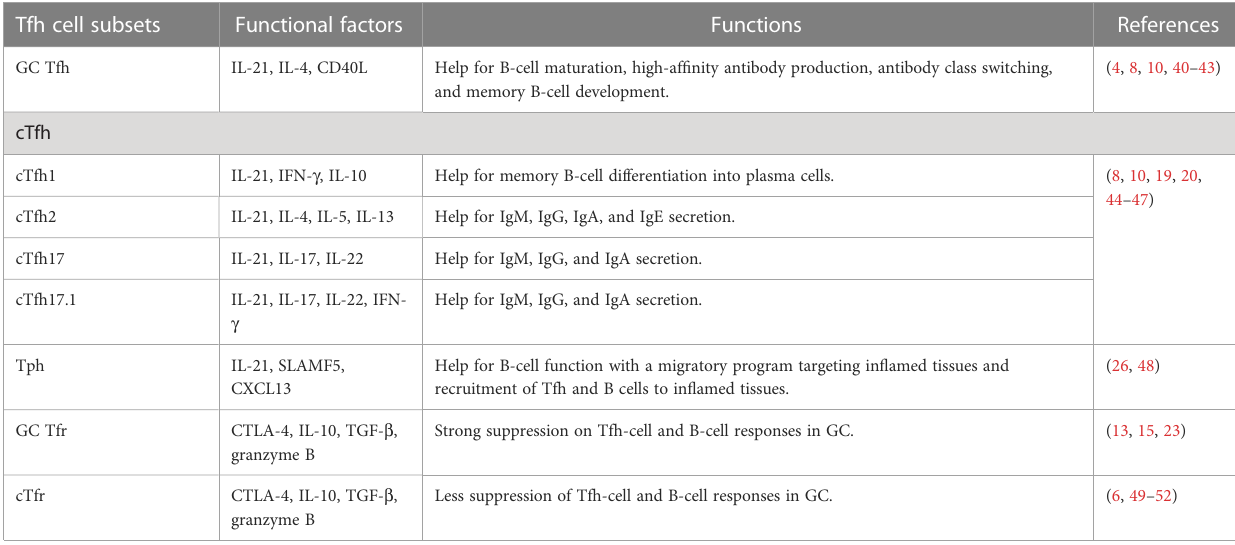
TABLE 1 Functional factors and roles in B-cell activation of Tfh and Tfr cells. Tfh cell